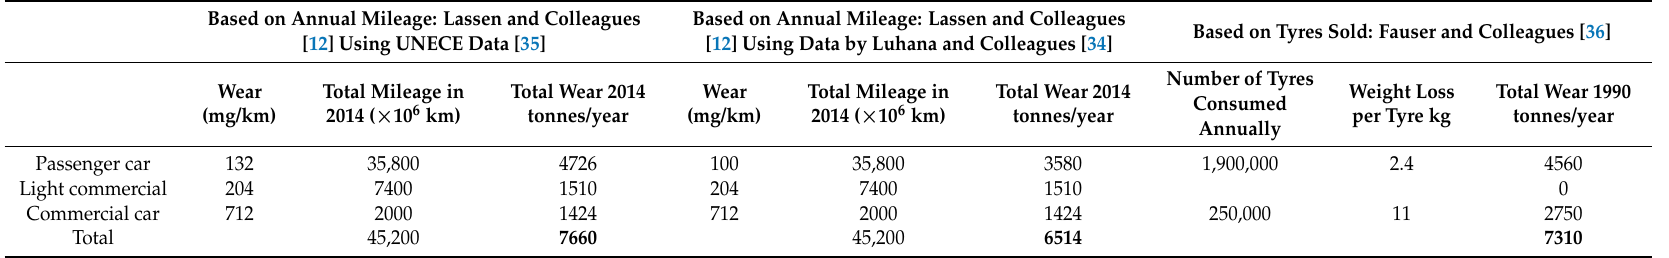
Based on Tyres Sold: Fauser and Colleagues